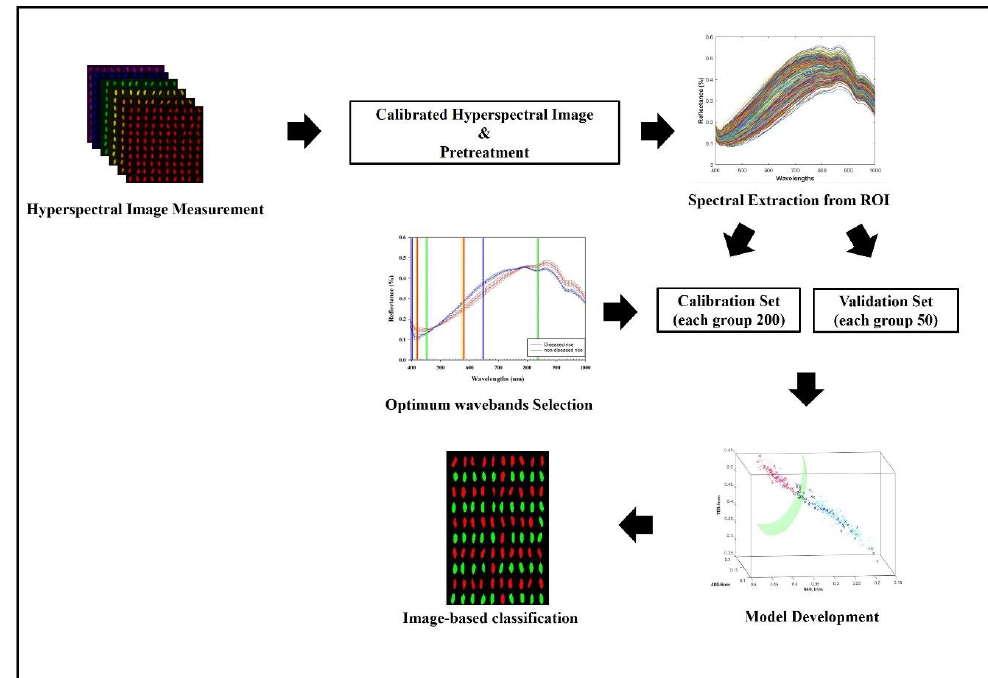
Figure 2. Key procedure steps used for the discrimination of diseased rice seed.